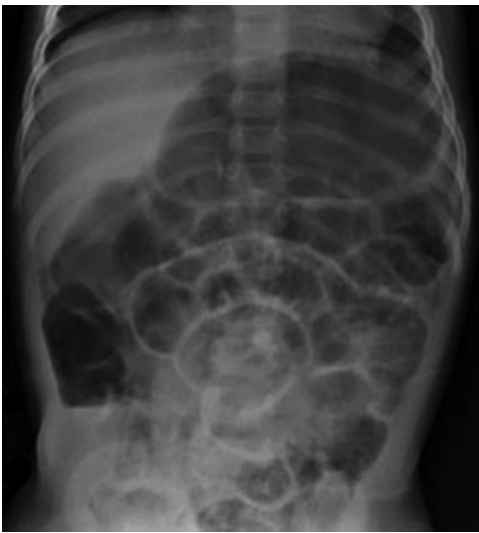
Fig. 2 Abdominal X-ray. Right lower quadrant fi xed air fl uid level and small bowel